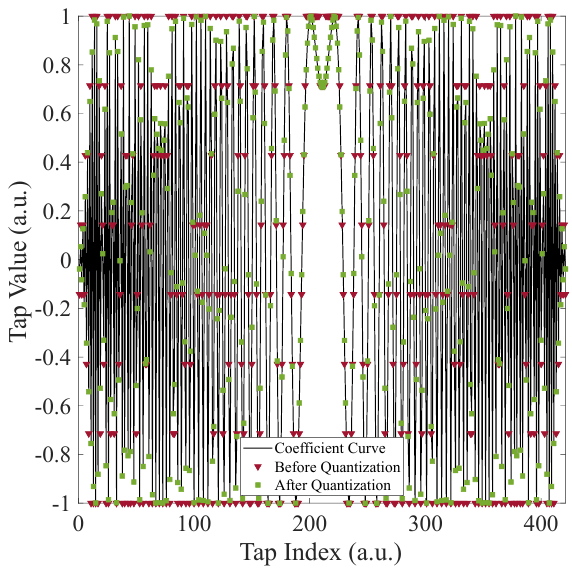
Figure 2. The real part of exact and quantized coefficients for M = 8 and N =